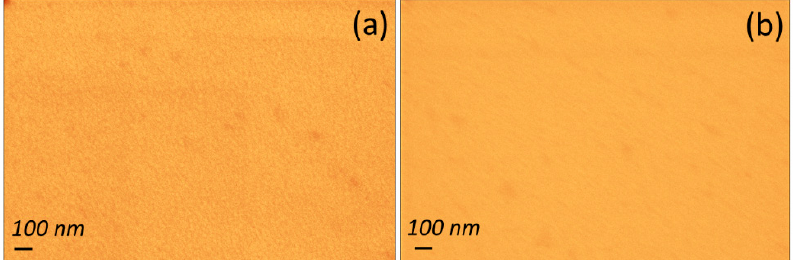
Figure 4. Scanning electron microscope images of LSCO films grown on STO ( a ) and LAO ( b ) substrates for the ~28 nm thickness.